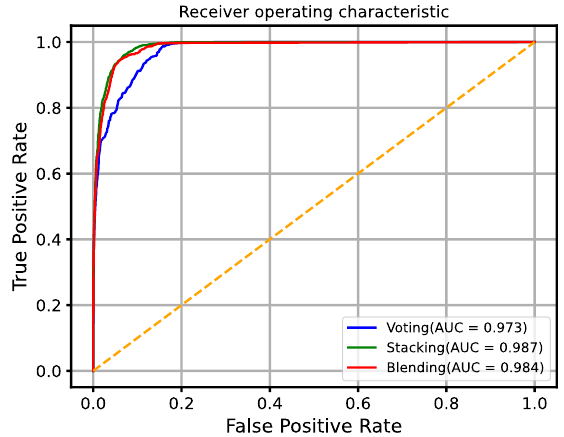
Figure 4. Diagram of the receiver operating characteristic of fusion models. Table 5. Evaluation results of the fusion model performance.